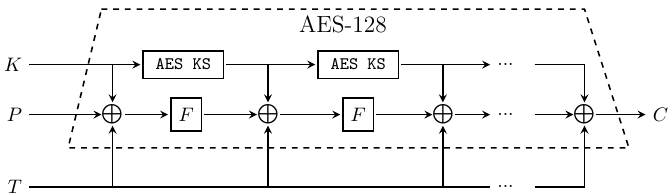
Figure 3: The Kiasu-BC tweakable block cipher based on AES